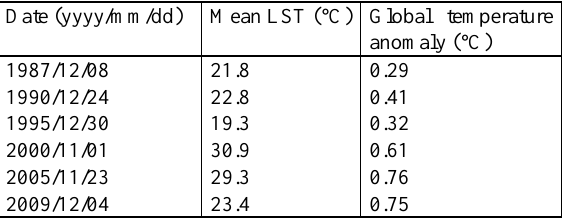
Table 3. The mean LST and global temperature